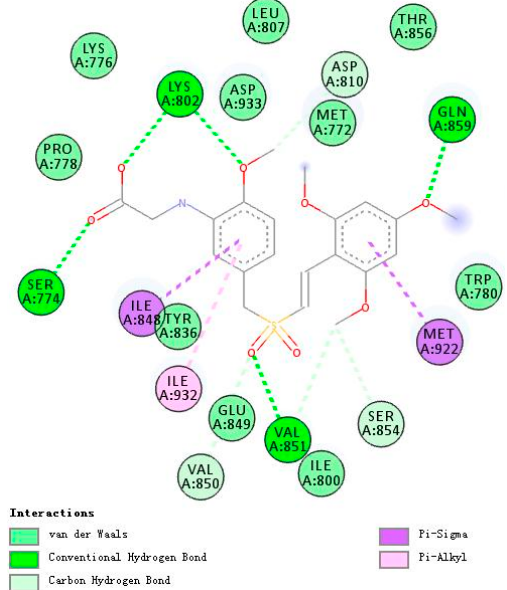
Figure 4. A 2D model of the interaction between rigosertib with the active site of PI3K α .